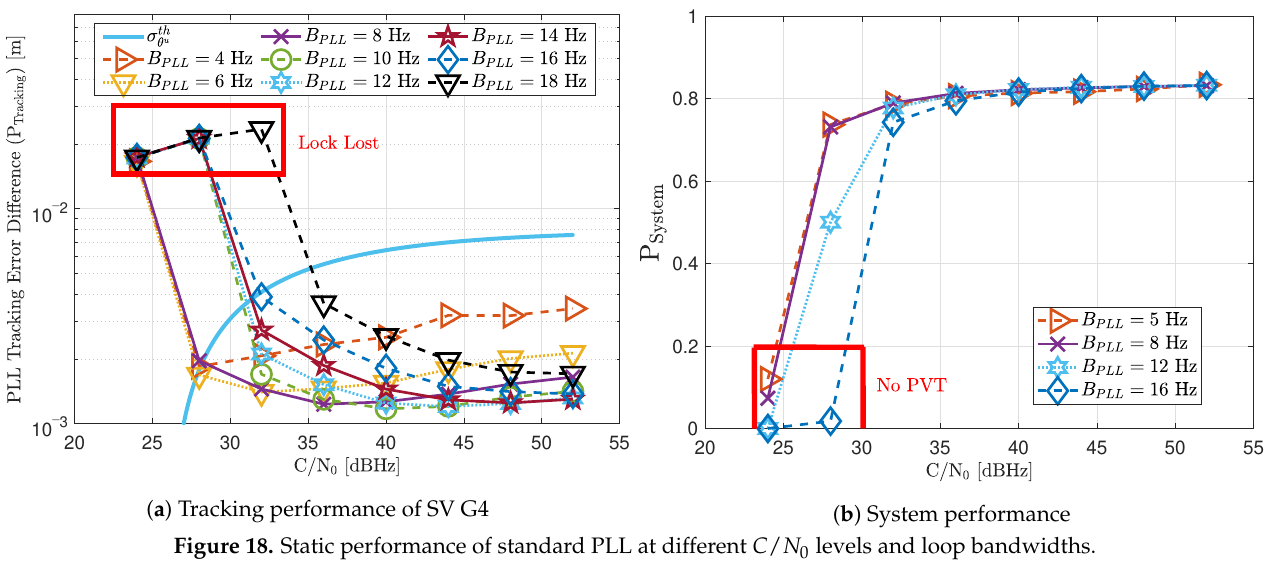
Figure 18. Static performance of standard PLL at different C / N 0 levels and loop